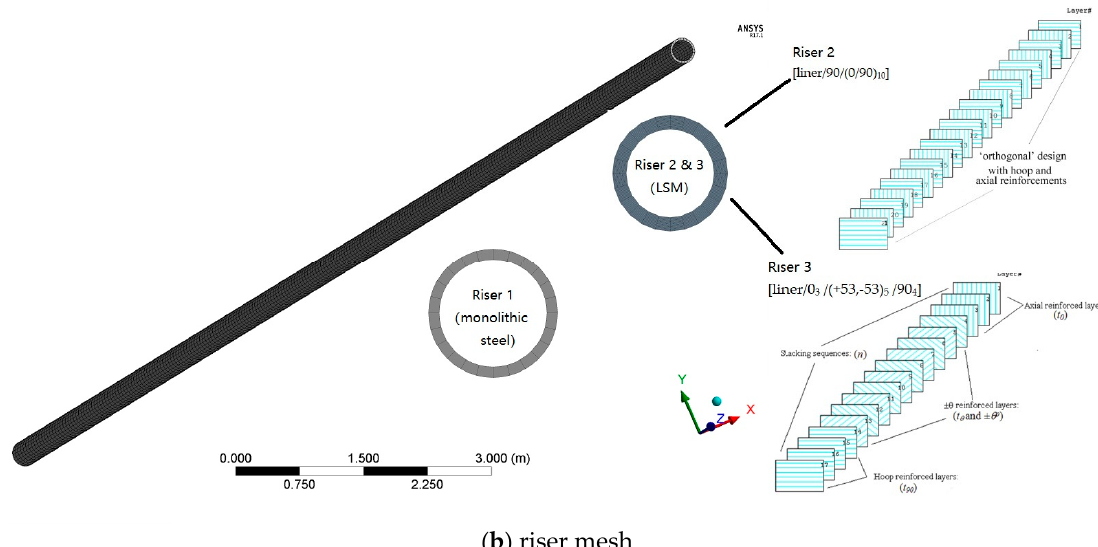
Figure 4. FE models for ( a ) flow zone and ( b ) steel and FRP composite risers.